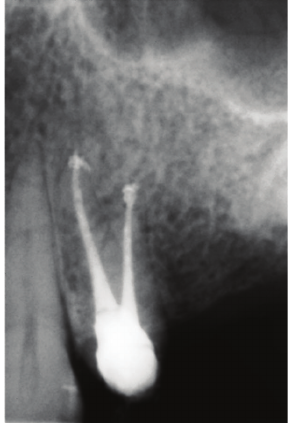
Figure 6: Approximately 4 weeks after the procedure root canals were